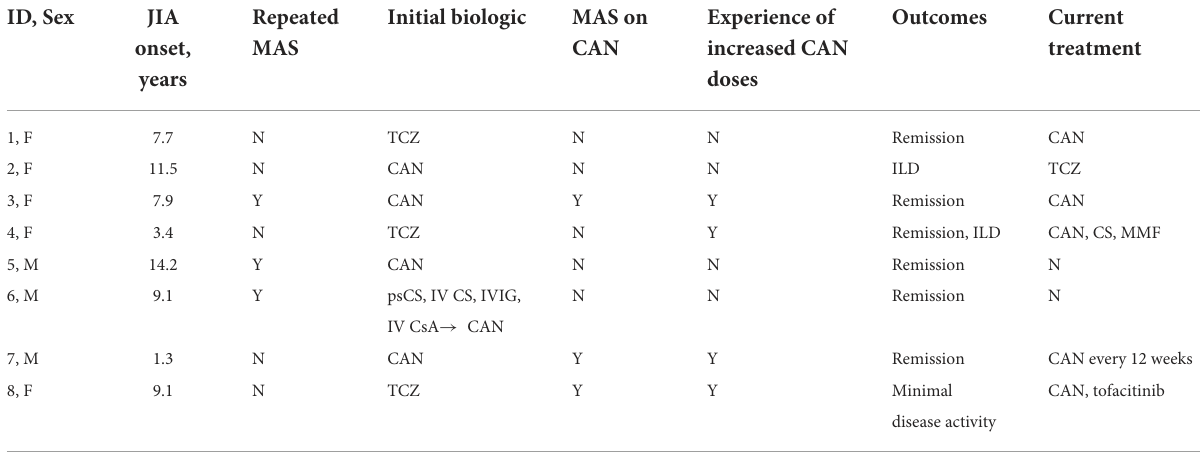
Outcomes Current treatment